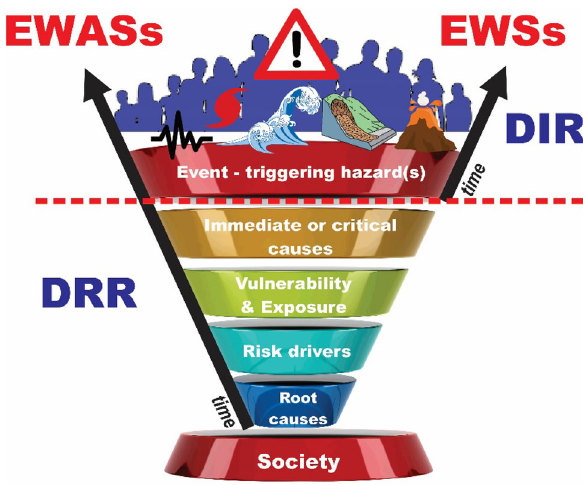
Fig. 4 Current early warning systems (EWSs) are merely focused on the hazard(s) as triggering mechanism(s) of disasters. Therefore, they contribute to disaster impact reduction (DIR), whereas early warning articulated systems (EWAS), from a FORIN perspective, call attention to the need for a clear understanding of the root causes and drivers of risk, as advanced in the FORIN approach in order to apply proper measures for disaster risk reduction